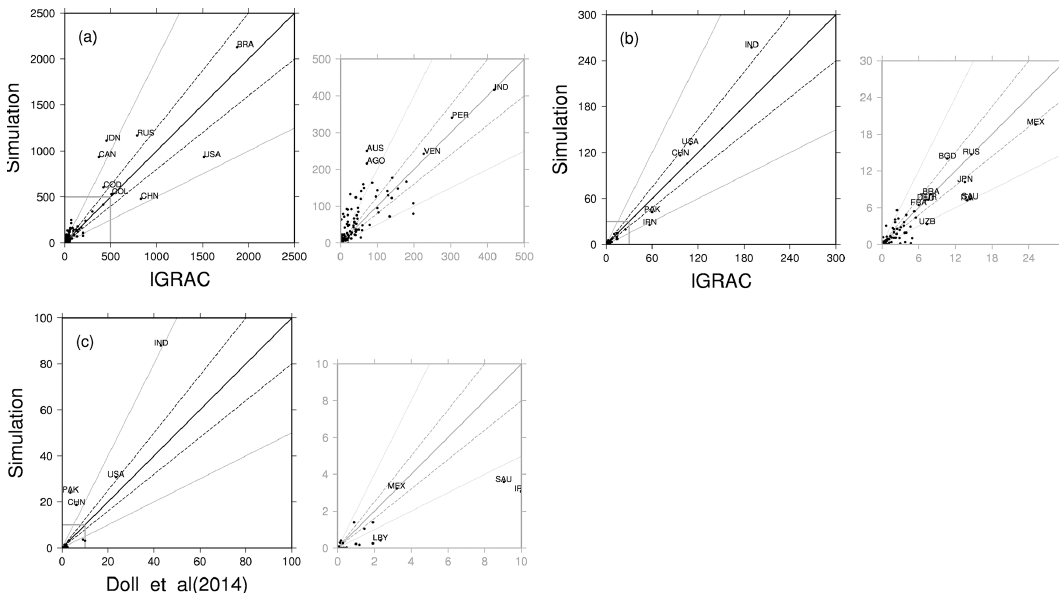
Figure 6. Comparison of the national estimates of (a) groundwater recharge with IGRAC (2004), (b) total groundwater abstraction with IGRAC (2004), and (c) groundwater depletion with Döll et al. (2014). The unit is km 3 yr − 1 . The right panels in gray are enlargements of the original figures. Thick and thin dotted lines show ± 20% and + 100% / − 50% differences, respectively.